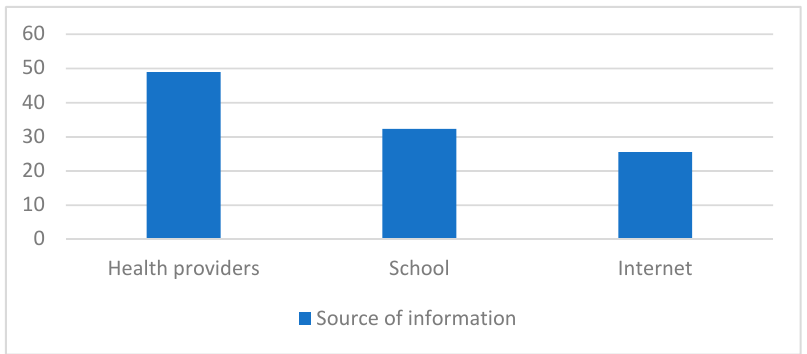
Figure 2. Previous education on contraceptive methods.